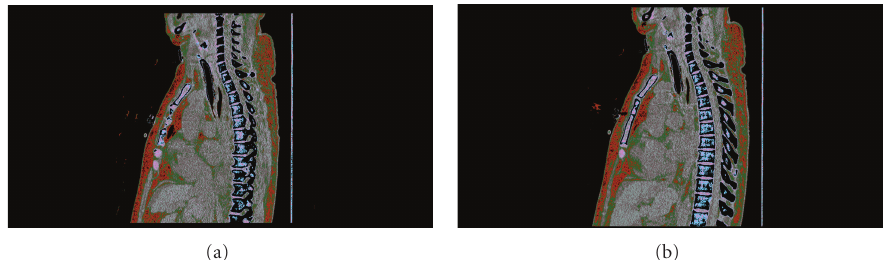
Figure 1: CT thorax, inspiration (a) and expiration (b), the figure tracheomalacia protocol; demonstrates near complete collapse of the distal trachea during expiration.